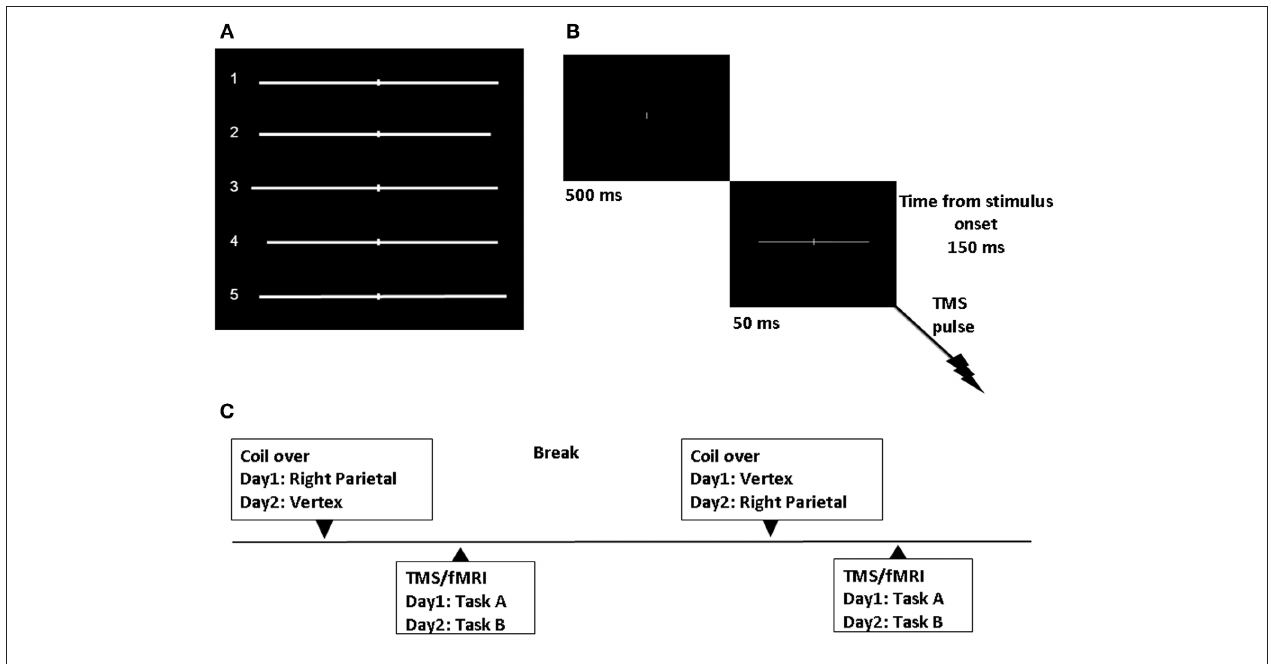
FIGURE 1 | Experimental design. (A) Symmetrically and asymmetrically bisected lines used in the study. Line 1 (symmetrically bisected): left segment 10.13 ◦ of visual angle/right segment 10.13 ◦ ; Line 2 (left-elongated): left segment 10.13 ◦ /right segment 9.47 ◦ ; Line 3 (left-elongated): left segment